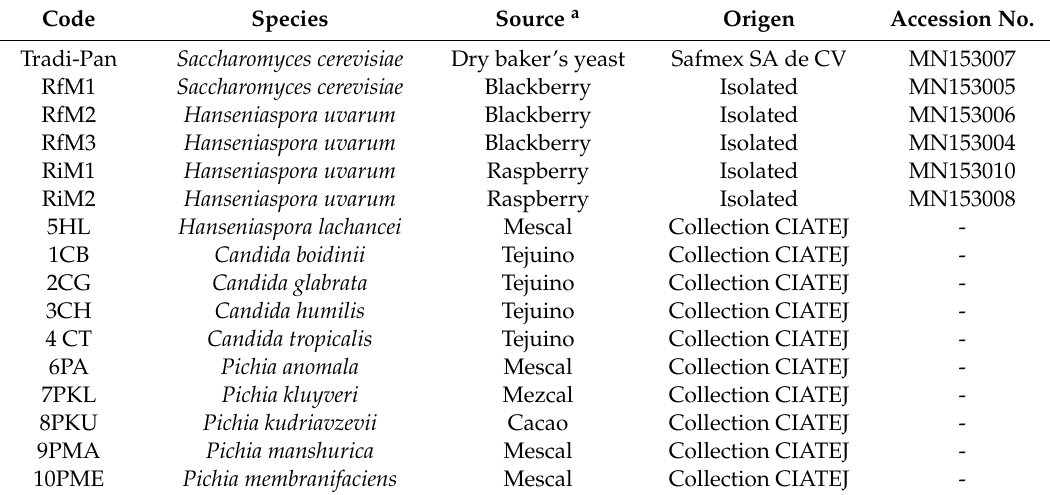
Table 1. Yeast species used in experiments including the identification code used in this study, source, origin, and GenBank accession number of partial 26S rDNA